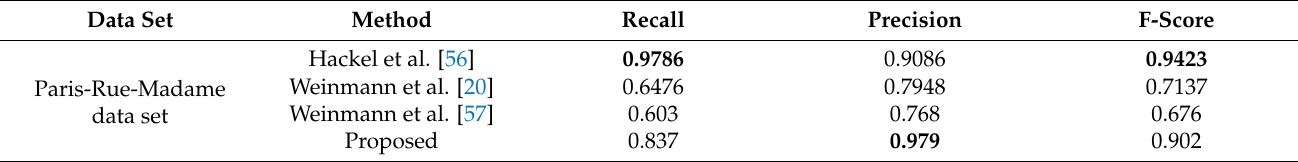
Table 5. Comparison results between the proposed and three existing methods on [51].